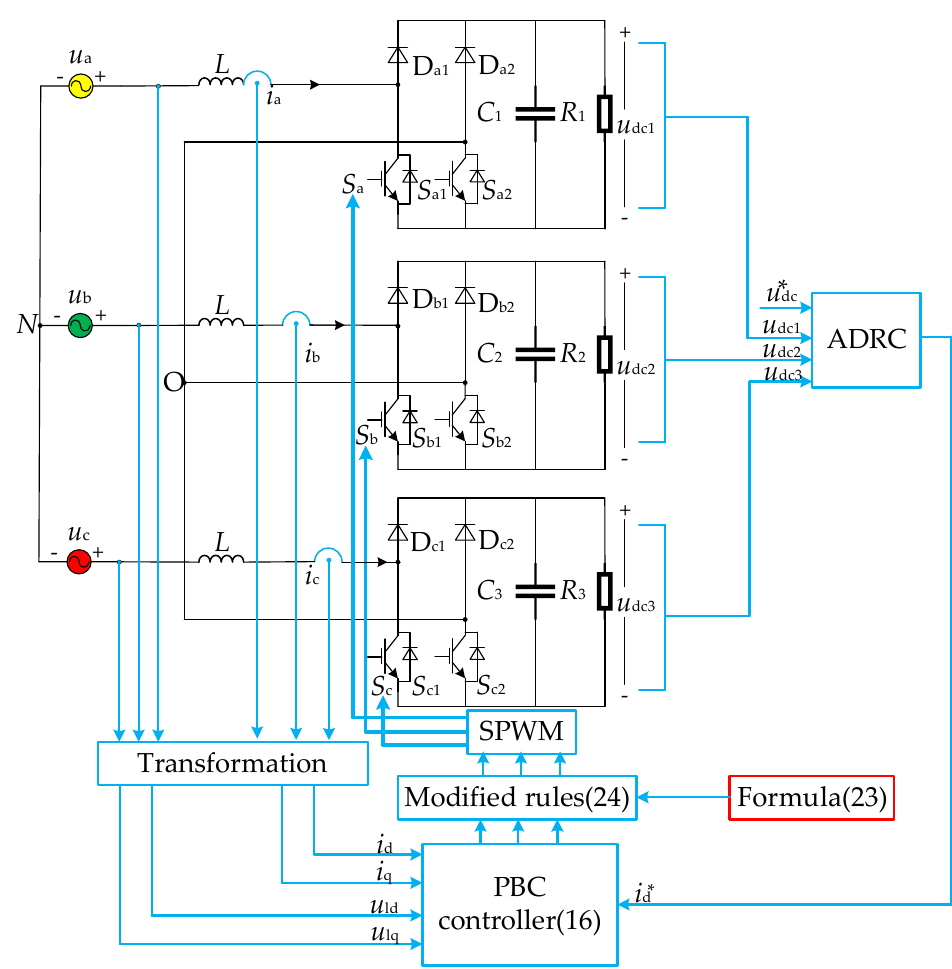
Figure 3. The hybrid nonlinear control scheme of the three-phase bridgeless rectifier.